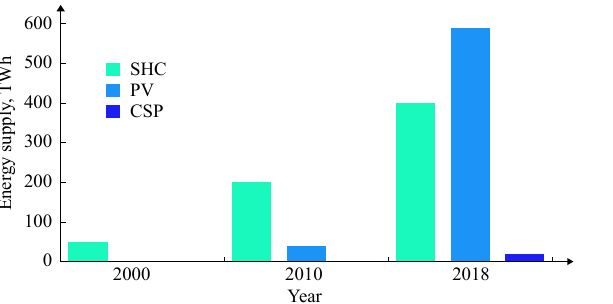
Figure 6. Change in global cumulative generation of the main solar technologies in a span of 3 decades. PV has witnessed the highest growth in the last decade, substantially more compared to CSP and SHC applications